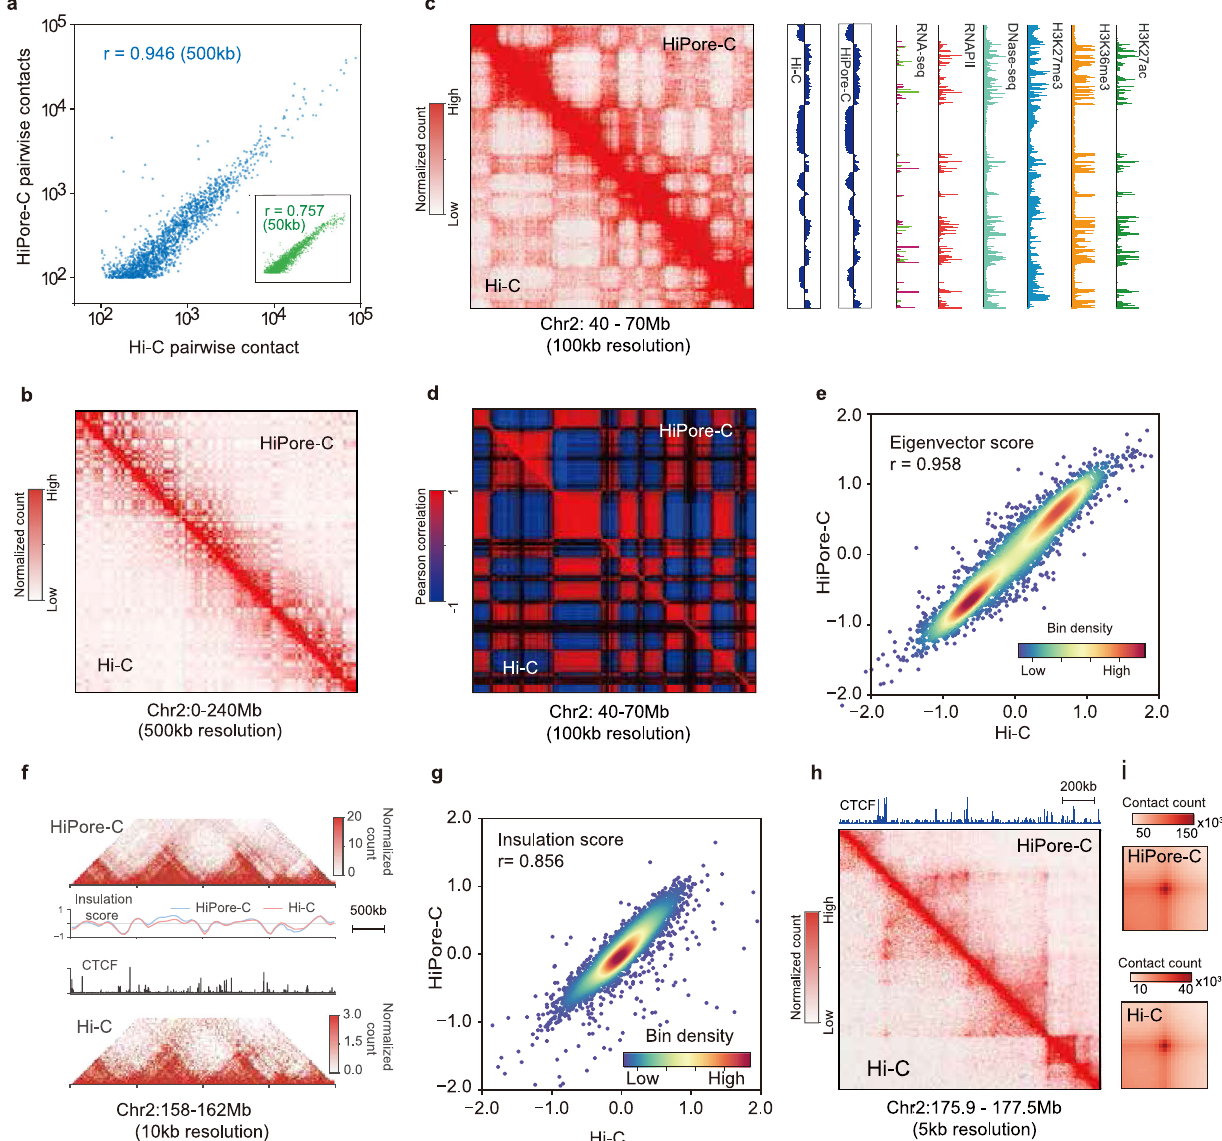
Fig. 2 | HiPore-C faithfully reproduces canonical 3D genome structures. a Pearson ’ s correlation of pairwise contacts between HiPore-C and Hi-C (Pairwise contact count>= 50; blue, 500kb resolution, n =13,613,408, P =0; green, 50kb resolution, n =12,498,125, P =0). b Comparison of contact maps between HiPore-C and Hi-C (upper right, HiPore-C; bottom left, Hi-C; 500kb resolution). c An exemplary region showing compartment comparison between HiPore-C and Hi-C (100kbresolution,tracksofeigenvectorscores,RNA-seq,DNase-Seq,andChIP-seq of RNApolymerase II(RNAPII),H3K27ac,H3K36me3,and H3K27me3areshownon the right.). d An exemplary region showing a Pearson ’ s correlation comparison